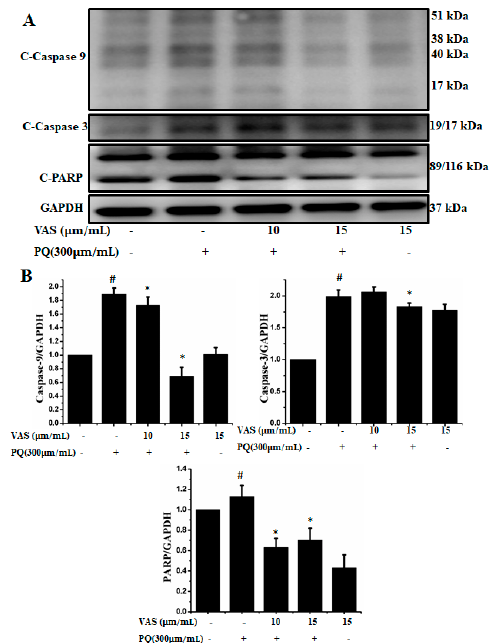
Figure 6. Vasicinone protected against paraquat-induced apoptosis in SH-SY5Ycells. ( A ) After pre-treatment with vasicinone for 24 h, SH-SY5Y cells were incubated with 300 µ M paraquat for another 24 h. The expression level of the cleaved-caspase-9, 3 and PARP were examined by using Western blot. ( B ) Cleaved-caspase-9, 3 and PARP were determined by densitometry. Three independent experiments were performed for this assay. Results are shown as the mean ± SD. # p < 0.01, compared with control cells; * p < 0.01, compared with paraquat-treated cells. Nutrients 2018 , 10 , x FOR PEER REVIEW